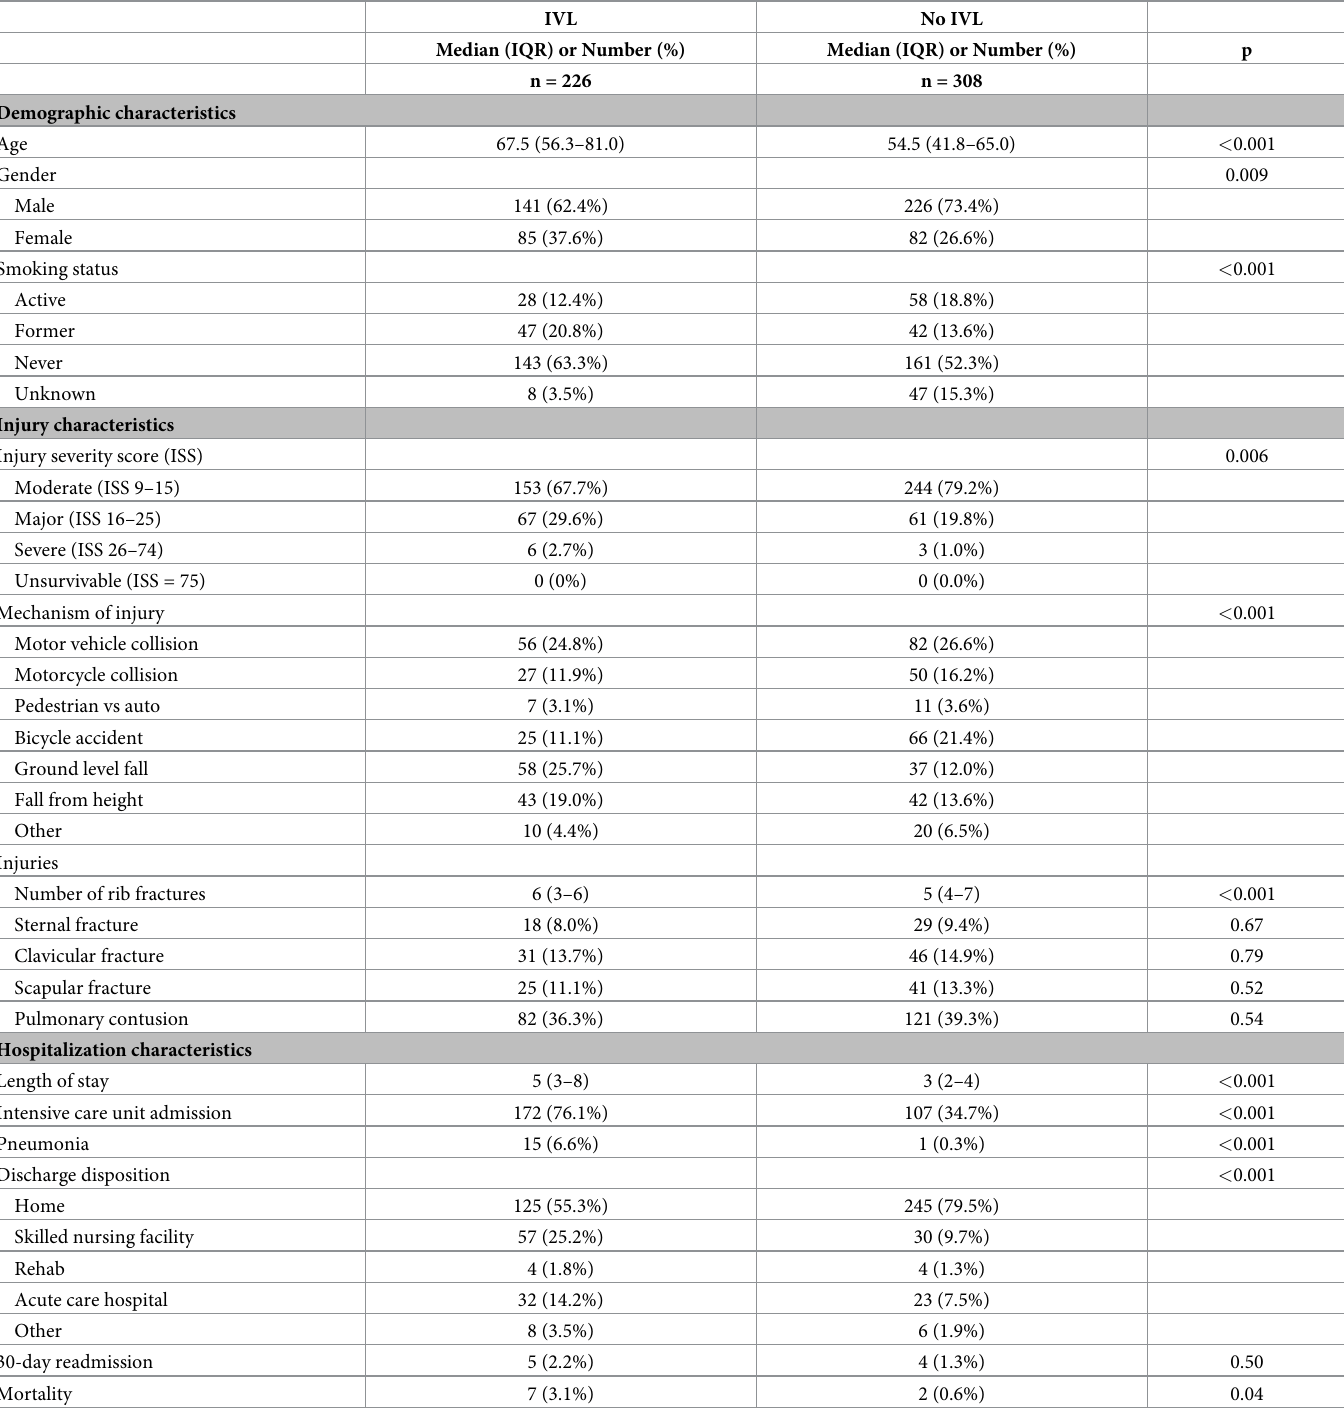
Table 1. Demographic, injury, and hospitalization characteristics of adult isolated chest wall injury patients on vs not on IVL